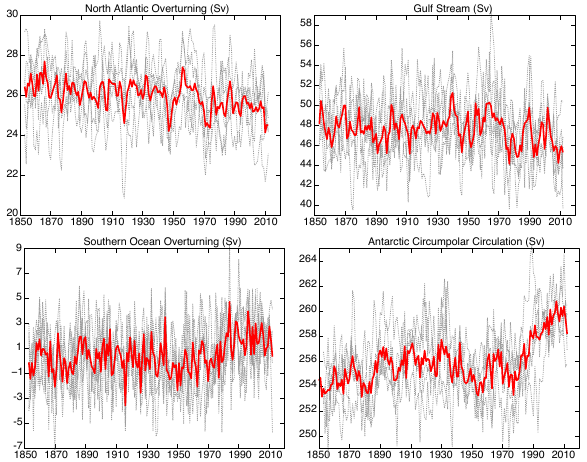
Fig. 28. Annual average zonal wind change (m s − 1 ) between 2000 forcing